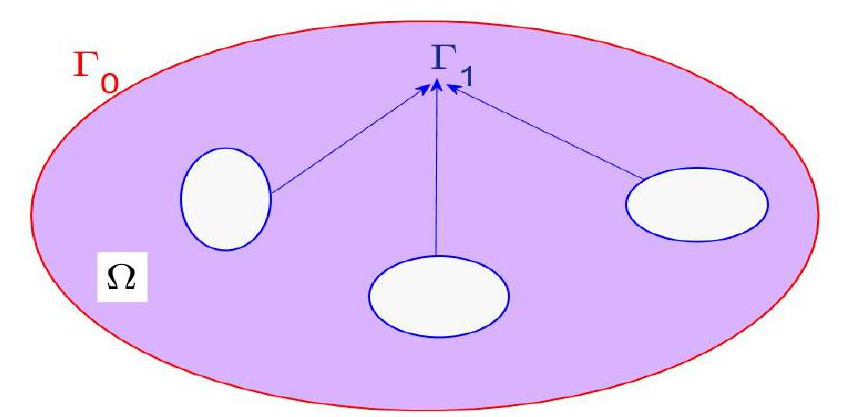
Figure 1. A simplified figure of Ω